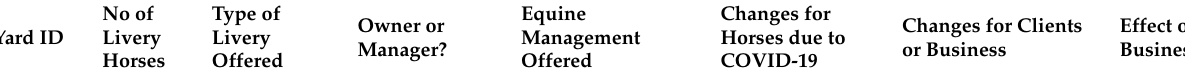
Table 1. Participants and livery types involved in the individual interviews, detailing changes made on each establishment. No of Type of Yard ID Livery Horses